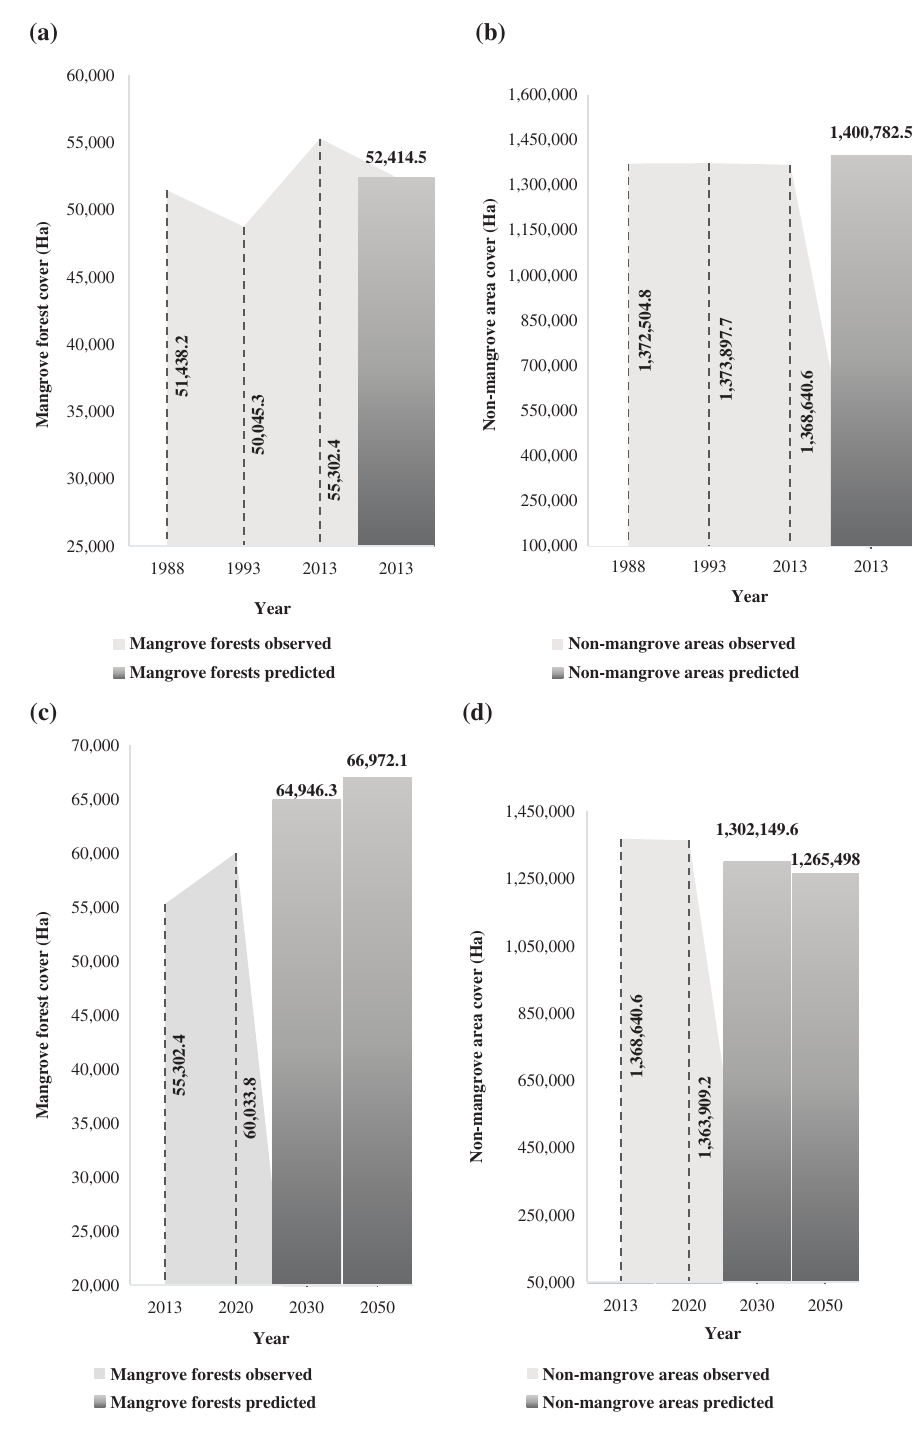
Figure 8 Projected probability of changes in mangrove forests and non-mangrove areas in Palawan. (a) Mangrove forests projection for 2013 using the time period 1988–1993. (b) Non-mangrove areas projection for 2013 using time period 1988–1993. (c) Mangrove forests projection for 2030 and 2050 using the time period 2013–2020. (d) Non- mangrove areas projection for 2030 & 2050 using the time period